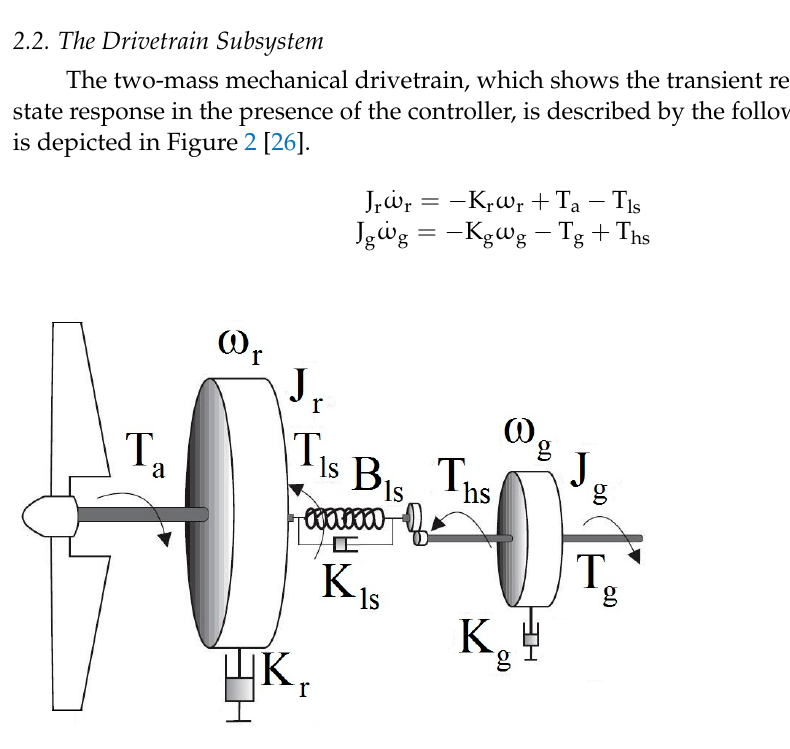
Figure 2. The drivetrain structure.